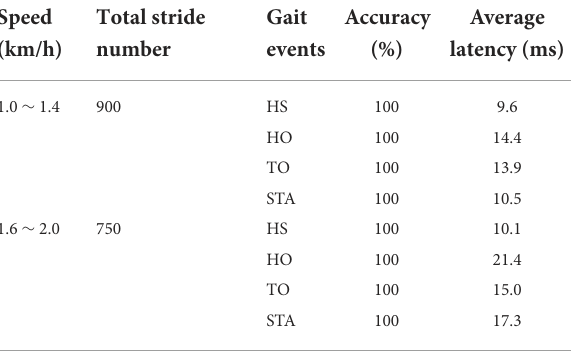
TABLE 2 Accuracy and time latency for gait event detection during various